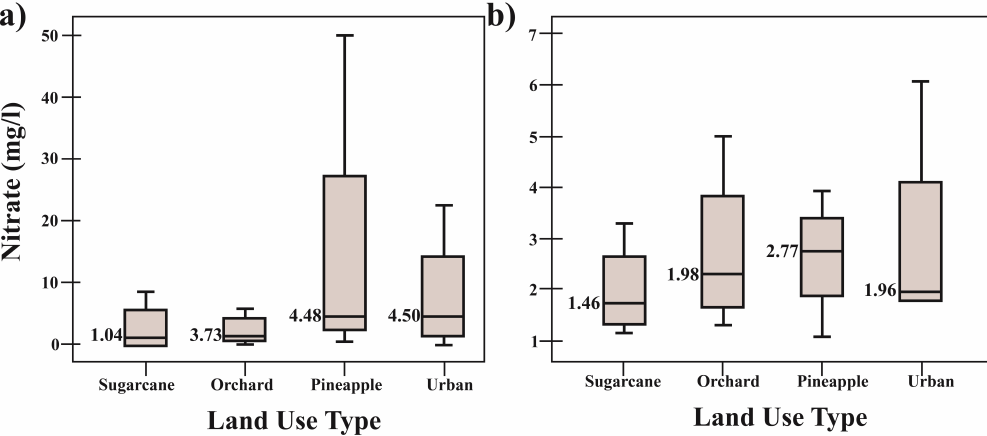
Figure 12. Box plot of NO 3 − concentrations in di ff erent land use types in ( a ) rainy season and ( b ) summer